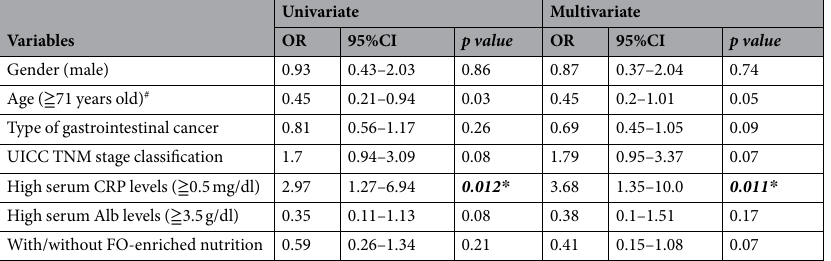
Table 2. Multivariate analysis to identify predictors of tolerance to chemotherapeutic treatment in GI cancer patients. # The median age at treatment was 71 years in this cohort. OR: Odds ratio. * p < 0.05 .